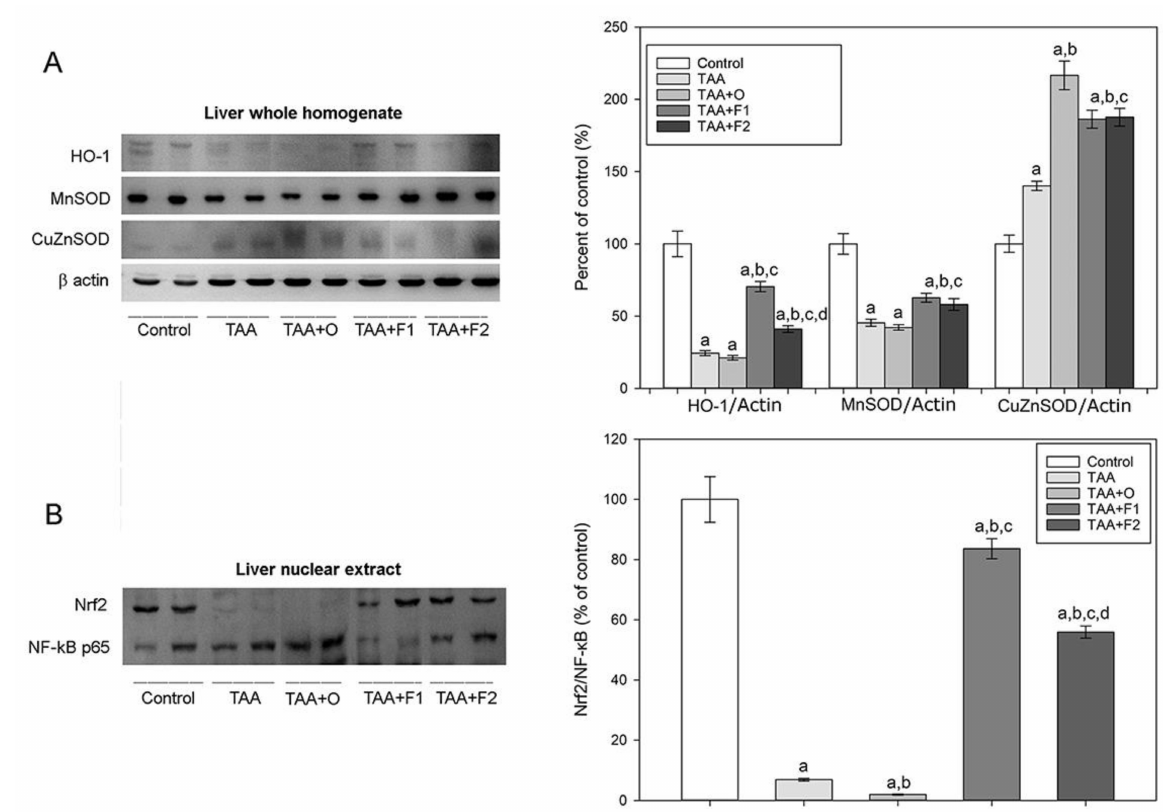
Figure 5. Protein expression levels of ( A ) haeme oxygenase-1 (HO-1), manganese superoxide-dismutase (MnSOD) and copper-zinc superoxide-dismutase (CuZnSOD) in whole liver homogenates, and ( B ) protein expression levels of total Nrf2 and NF-kB p65 in nuclear extracts in control, and rats treated with thioacetamide (TAA), thioacetamide + virgin olive oil (TAA+O), thioacetamide + C60 fullerene lower dose (TAA+F1), and thioacetamide + C60 fullerene higher dose (TAA+F2). Data are given as mean ± standard error. Minimal significance level: p < 0.05. Significantly different: a in respect to Control; b in respect to TAA; c in respect to TAA+O, and d in respect to TAA+F1 group. The number of animals per group =